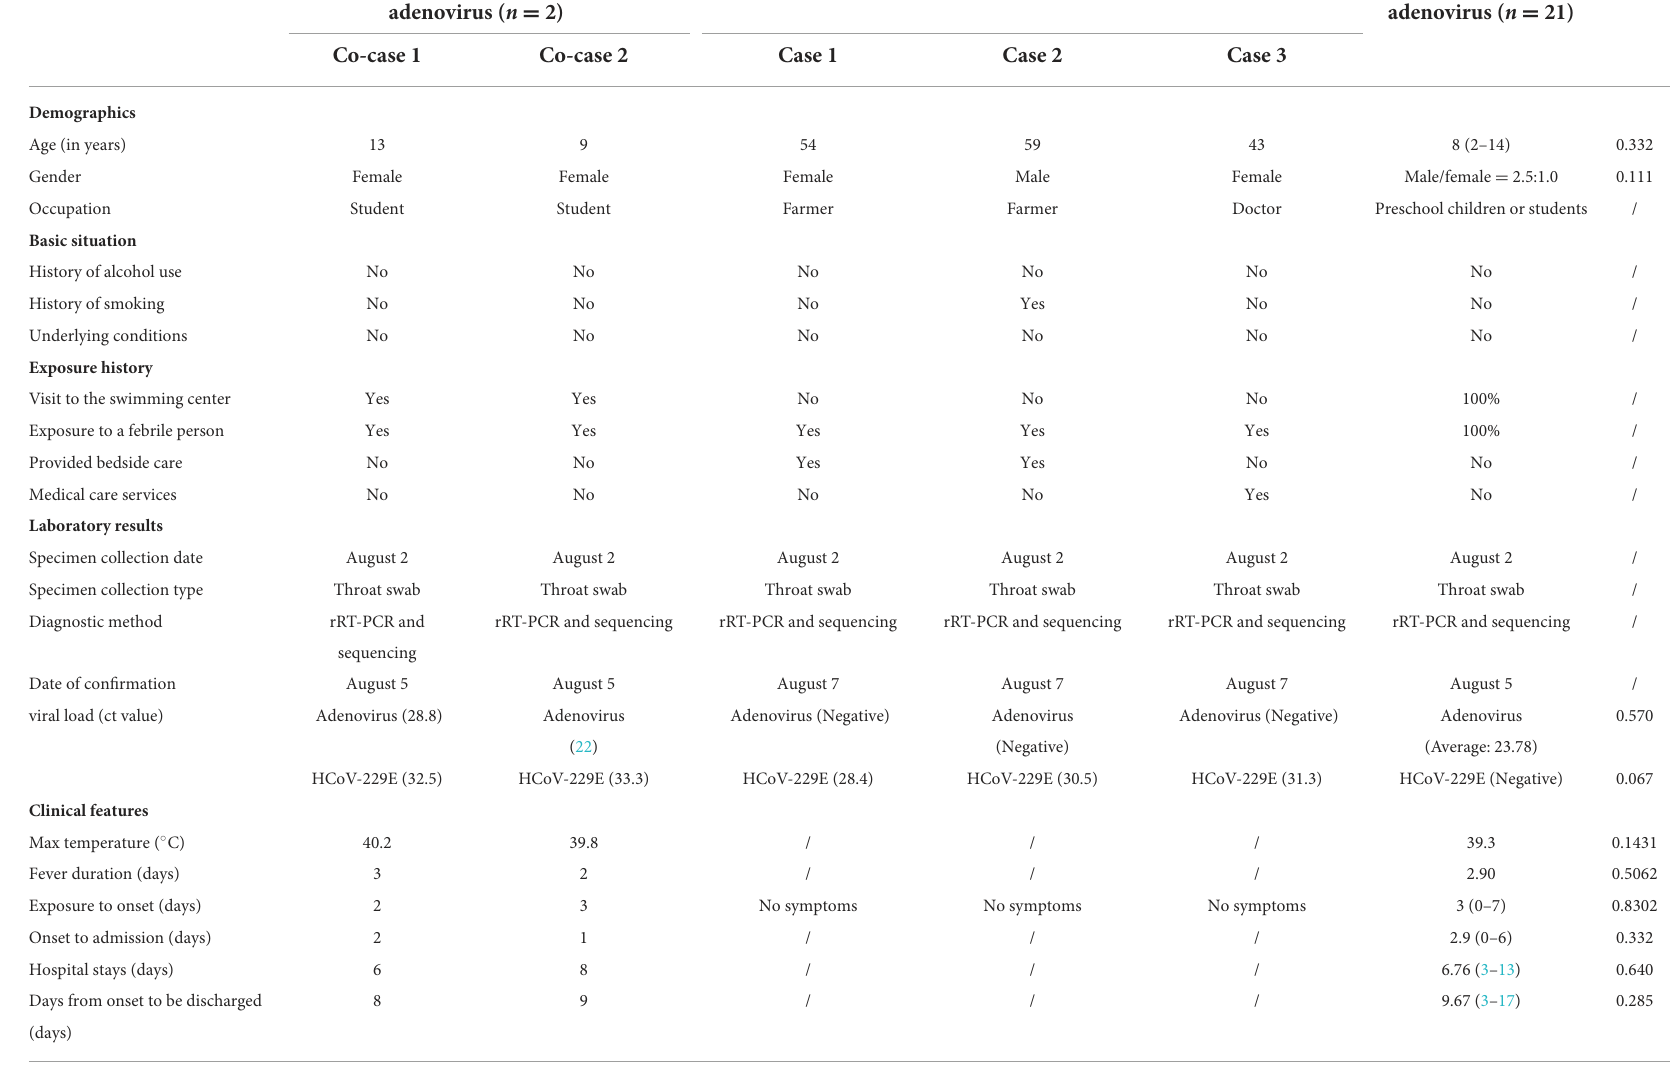
TABLE 1 Comparison of the characteristics of two children coinfected with HCoV-229E and adenovirus admitted to different rooms of the same pediatric ward and mono-infections with HCoV-229E and Adenovirus in Lishui, Zhejiang Province, July–August 2019. Characteristic Coinfection withHCoV-229E and adenovirus ( n =